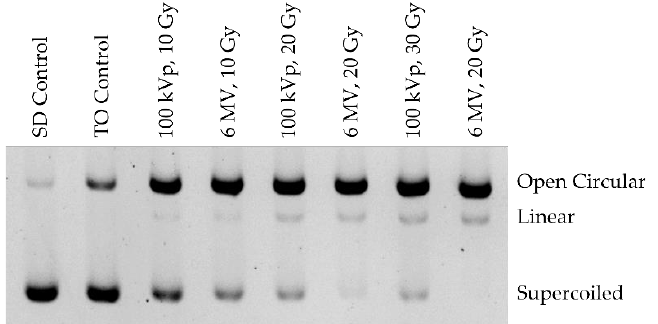
Figure 5. A representative gel run showing the three plasmid DNA conformations separated into bands. The DNA in this example was irradiated but had no enzymatic treatment applied. For easy visualization of bands, the image is shown over exposed and inverted.